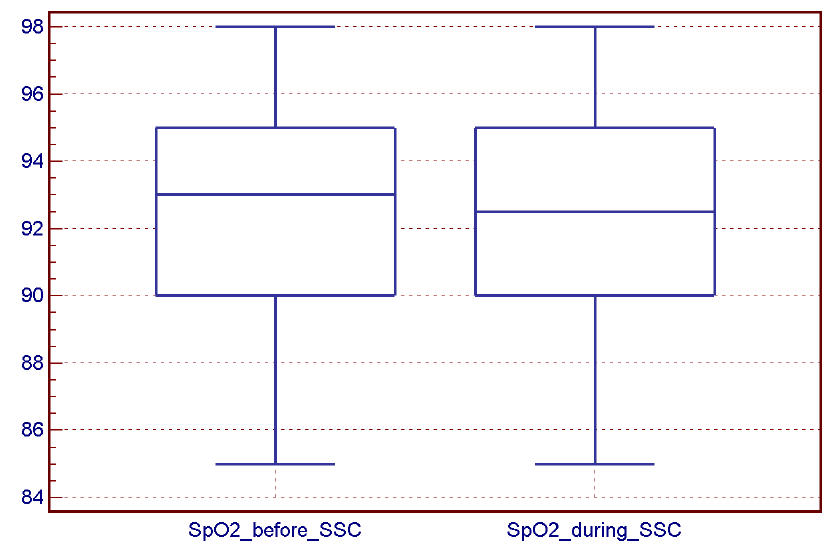
Figure 3. Infants’ SpO2 before (median 93.0, range 85– 98) and during an SSC session (median 92.5, range 85 – 98) ( p = 0.76). range 85–98) ( p = 0.76).